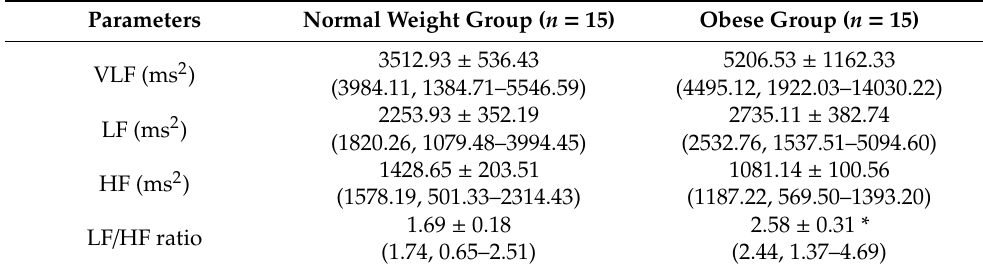
Table 8. Frequency domain of heart rate variability in normal weight and obese groups. Mean ± SE (median, minimum-maximum) are reported.